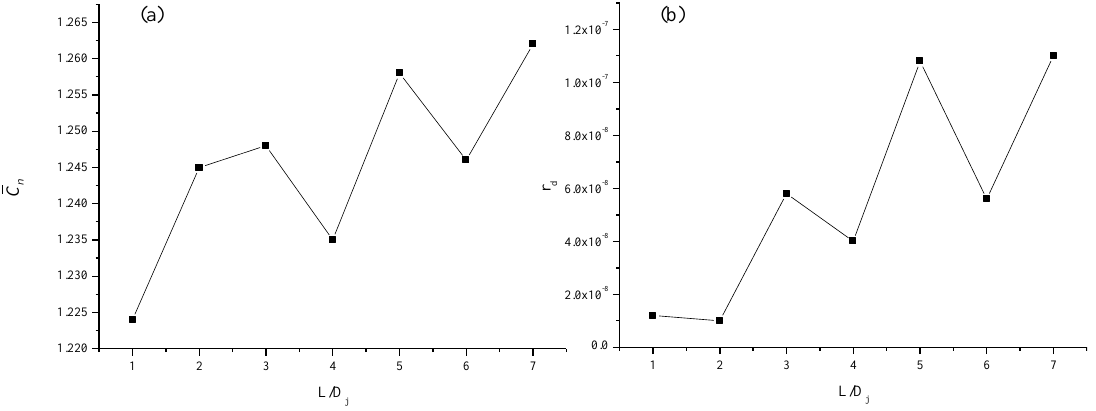
Figure 8. Effect of cavity length on the process of deformation. ( a ) Variation of C n and L obtained by experiment. ( b ) Variation of r d and L obtained by calculation.